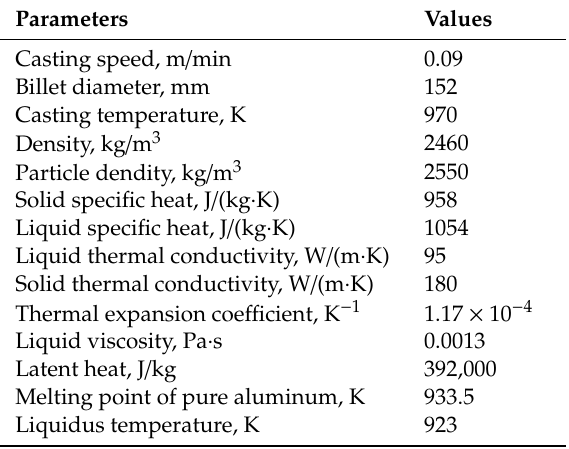
Table 2. Operation parameters and thermo-physical